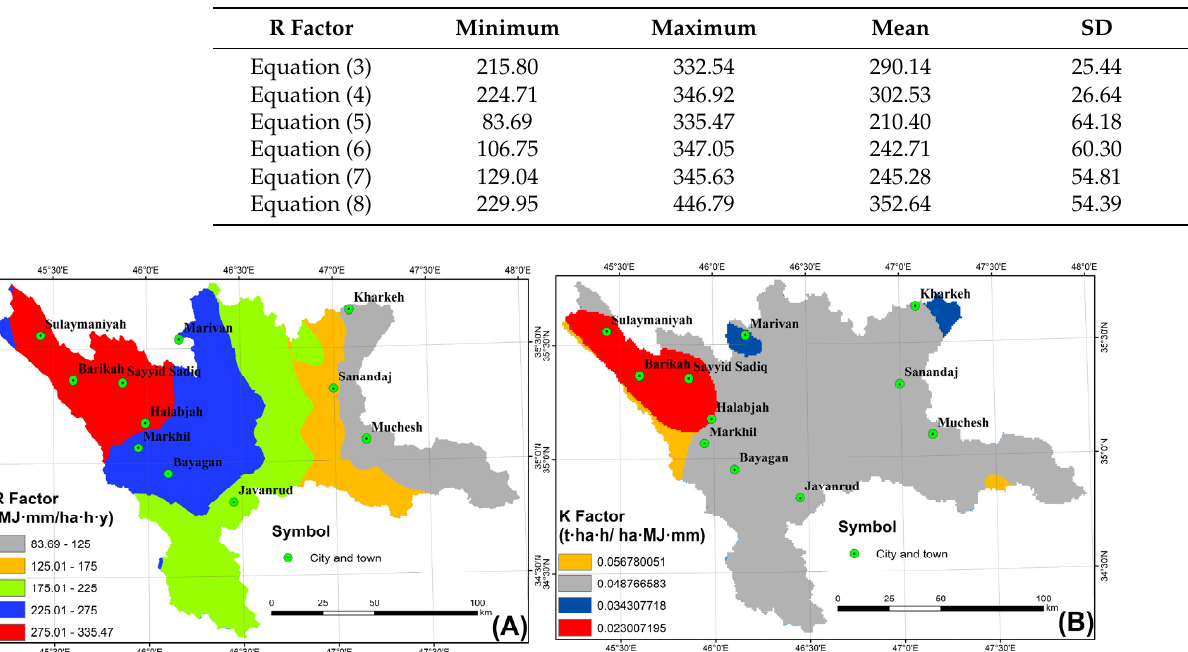
Table 8. R-factor parameters of the used models.